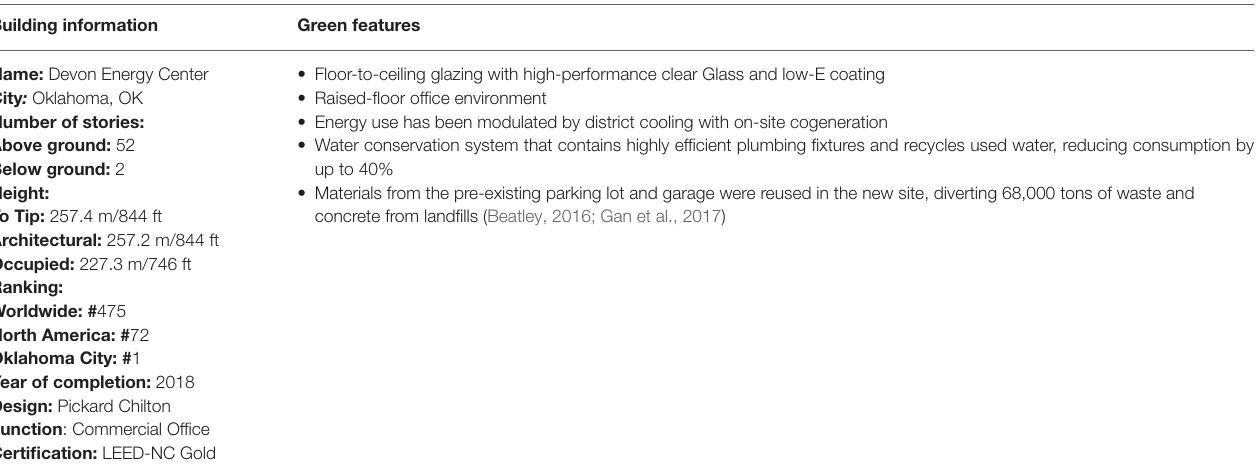
TABLE 6 | Devon Energy Center: Key green features. Building information Green features